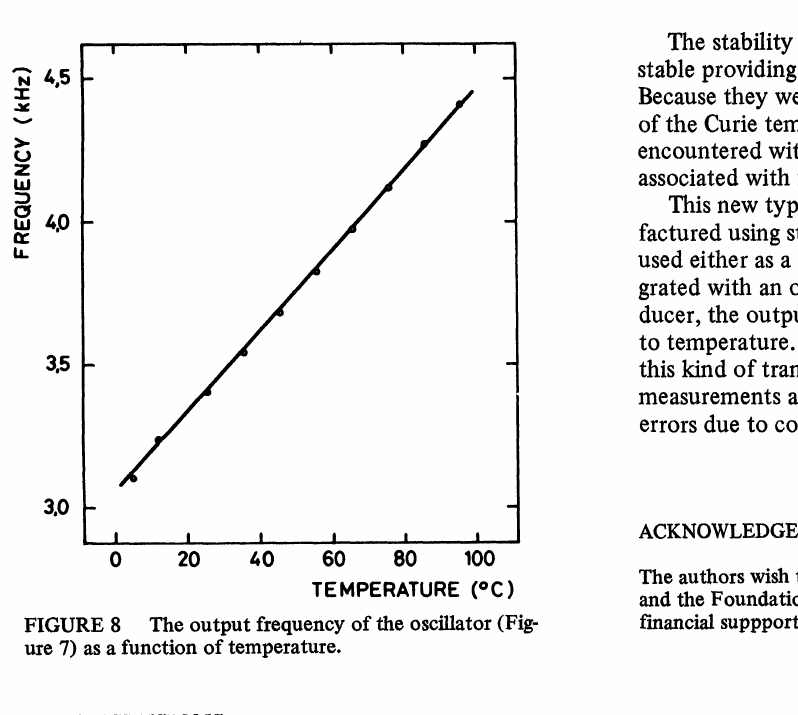
The output frequency of the oscillator (Fig- ure 7) as a function of temperature.